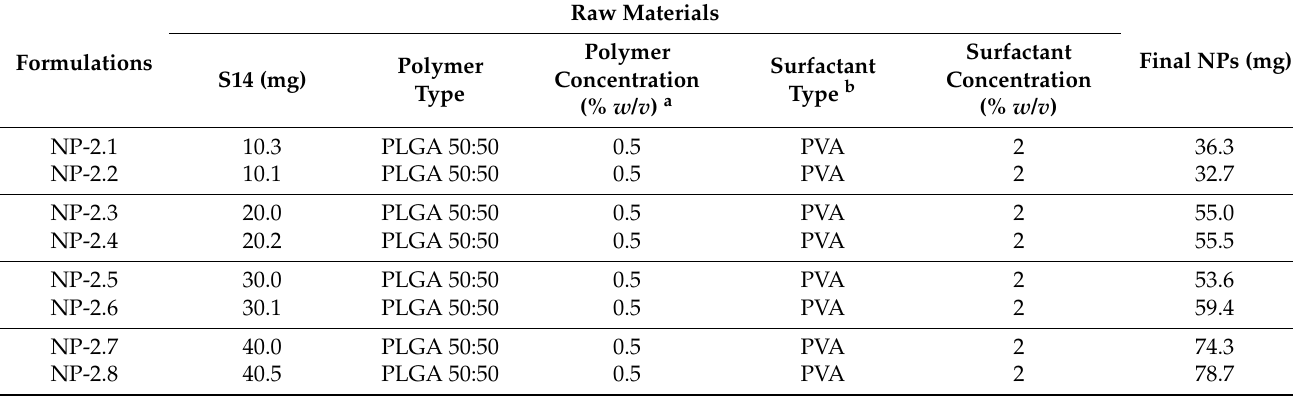
Table 2. Composition of PLGA nanoparticles prepared by nanoprecipitation methodology.